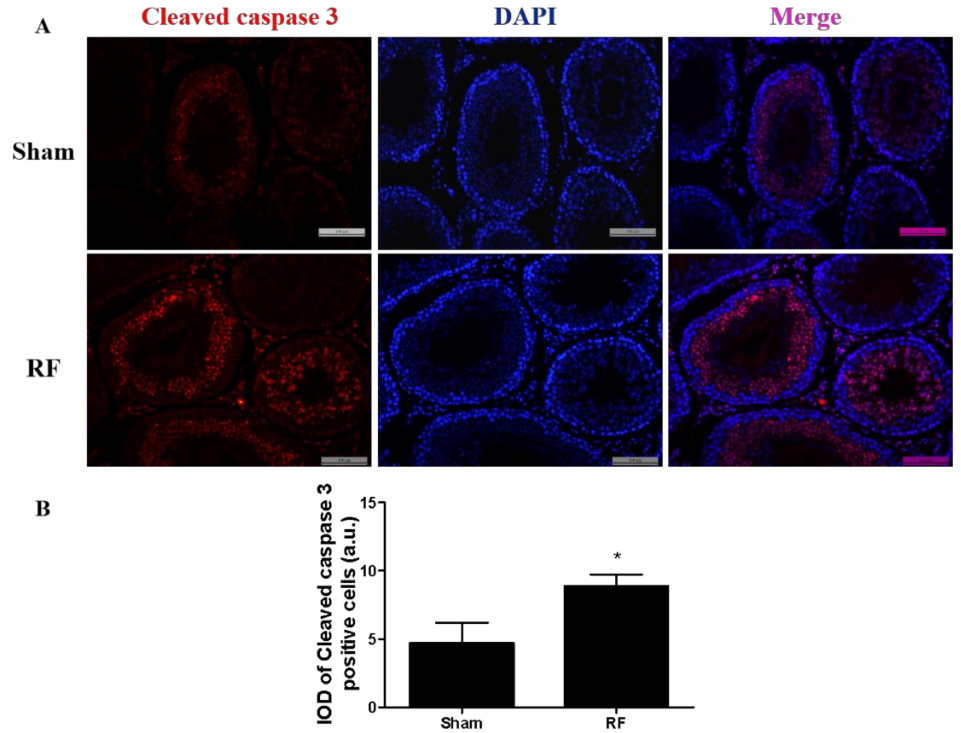
Figure 7. The effect of one-month 220 MHz pulsed modulated RF exposure on cleaved caspase 3 protein in testicular tissue of SD rats. ( A ) Immunofluorescence of cleaved caspase 3, DAPI: 4 (cid:48) ,6-diamidino-2-phenylindole; ( B ) the integrated optical density (IOD) of cleaved caspase 3 in the testis. N = 3 for each group. The values were expressed as means ± SEM and were analyzed by student t -test. * p < 0.05 compared with the sham